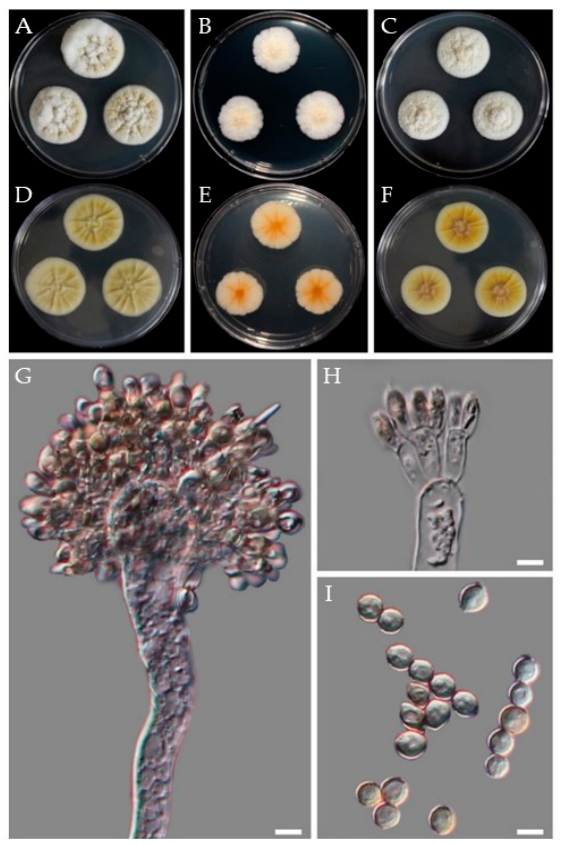
Figure 8. Morphological features of the isolate CMML21–4. Obverse and reverse colony morphol ‐ ogy on CYA ( A , D ), MEA ( B , E ), and YES ( C , F ) after 7 days at 25 °C. Structures and shapes of conid ‐ iophores ( G , H ); conidia ( I ). Scale bars, ( G – I ) = 5 μ